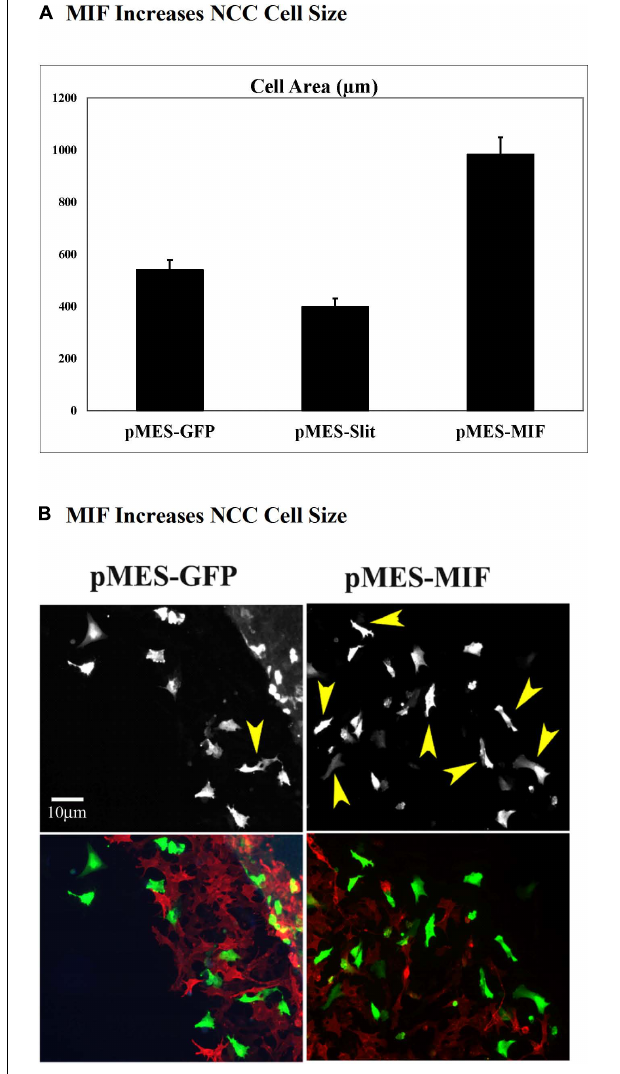
FIGURE 12 | Expression of MIF by tNCC changes cell morphology. Chicken embryos NT were electroporated with pMES-GFP, pMES-Slit2, or pMES-MIF plasmids and cultured overnight. Next day cultures were fixed and tNCC cell areas measured (2D). (A) Graph for results from measuring more than 100 cells from at least 5 cultures. MIF doubled the cell area of tNCC compared with control, while Slit2 reduced their sizes. (B) Fluorescent images from one sample tNCC culture. Top panel corresponds to GFP channel for either GFP control or MIF-GFP. Bottom panel shows tNCC cultures overlap immunofluorescence with HNK1 (red) and GFP (green) plasmid